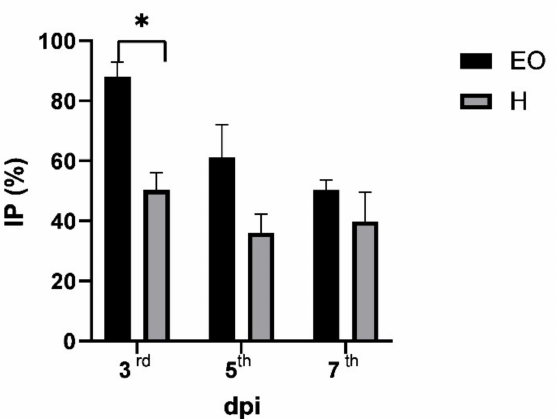
Figure 2. Percentage of inhibition (IP) of local lesions on leaves of tretaed host plants inoculated with tobacco mosaic virus compared with control plants on days 3, 5, and 7 postinoculation (dpi). Prior to inoculation, treated plants were sprayed with essential oil (EO) or hydrosol (H) of H. perforatum ssp. veronense for two consecutive days. Error bars show the standard deviation of triplicate analyses; significant differences were determined by t -test and marked with